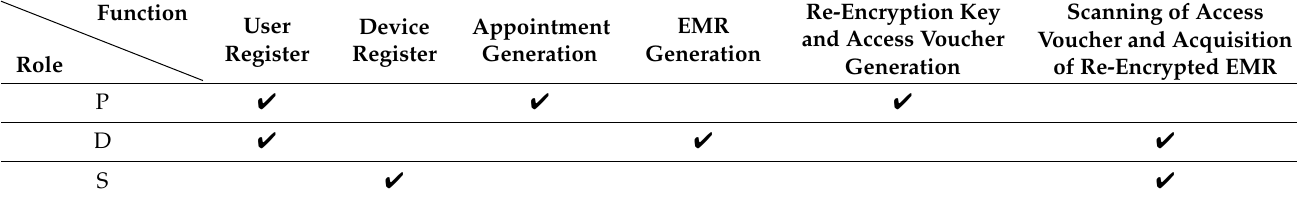
Table 3. The attribute-based access control in the proposed